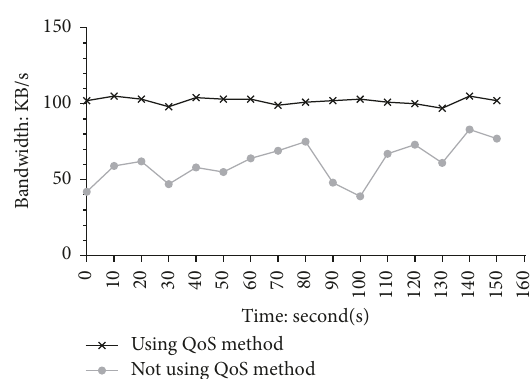
Figure 7: Bandwidth usage for MicroSIP in two